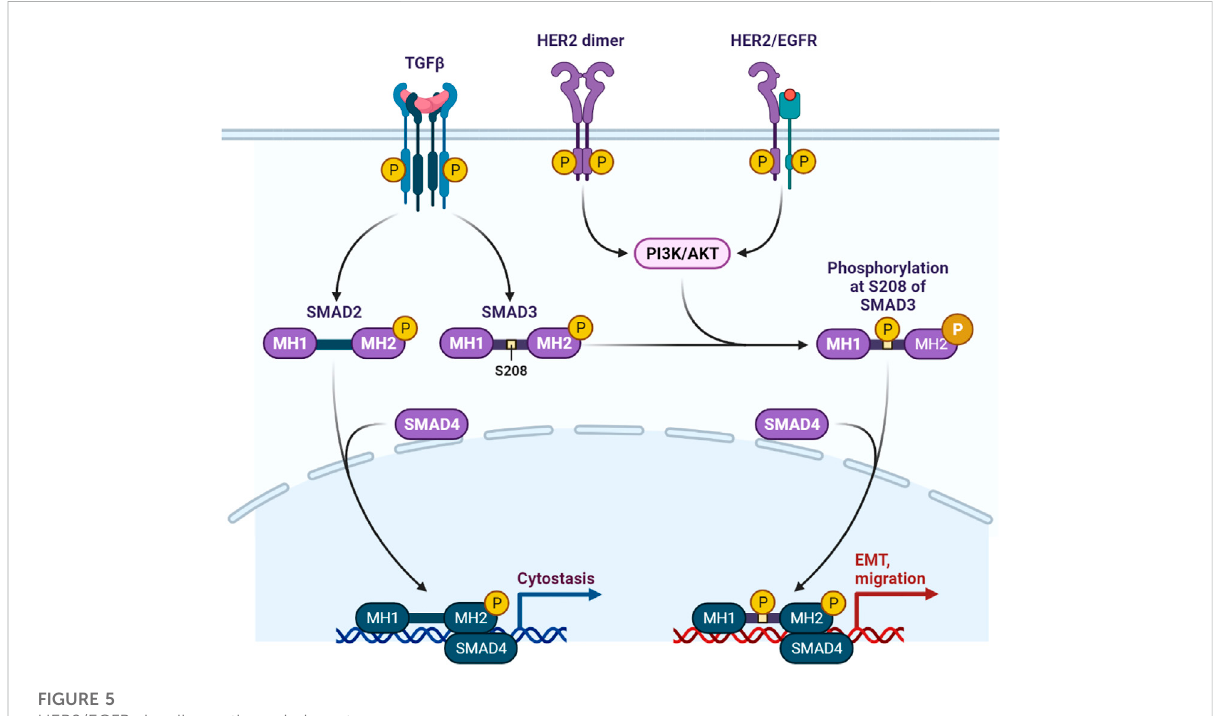
FIGURE 5 HER2/EGFR signaling pathway in breast